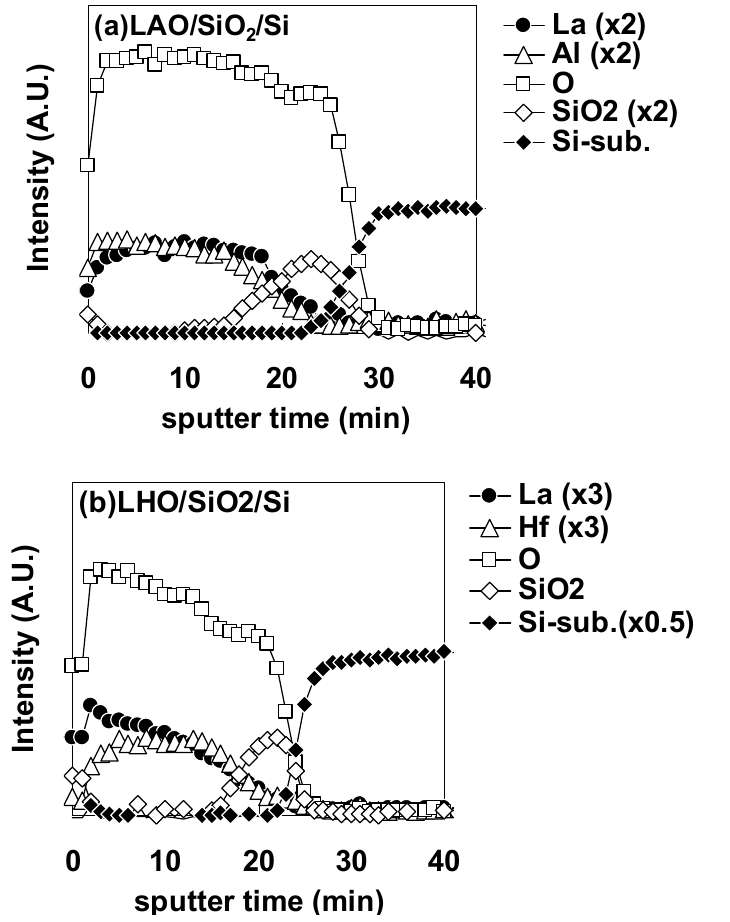
/Si and ( b ) La Hf O (LHO)/SiO /Si 2 2 2 7 2 ) and Si metal 2